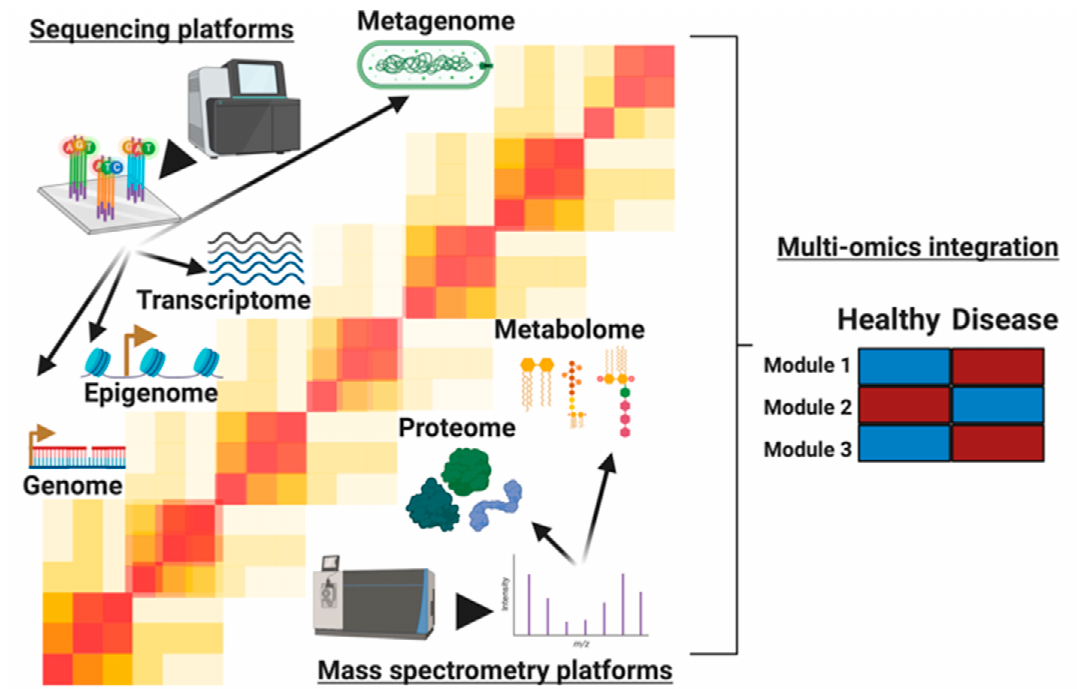
Figure 1. The molecules profiled in multi-omics studies. We describe 6 levels of information, starting from the bottom to the top: genome, epigenome, transcriptome, proteome, metabolome, and metagenome. The genome, epigenome, transcriptome, and metagenome are profiled by sequencing-based technologies such as sequencing by synthesis, depicted here, to profile a comprehensive set of nucleic acid molecules. On the other hand, mass spectrometers generate proteome and metabolome